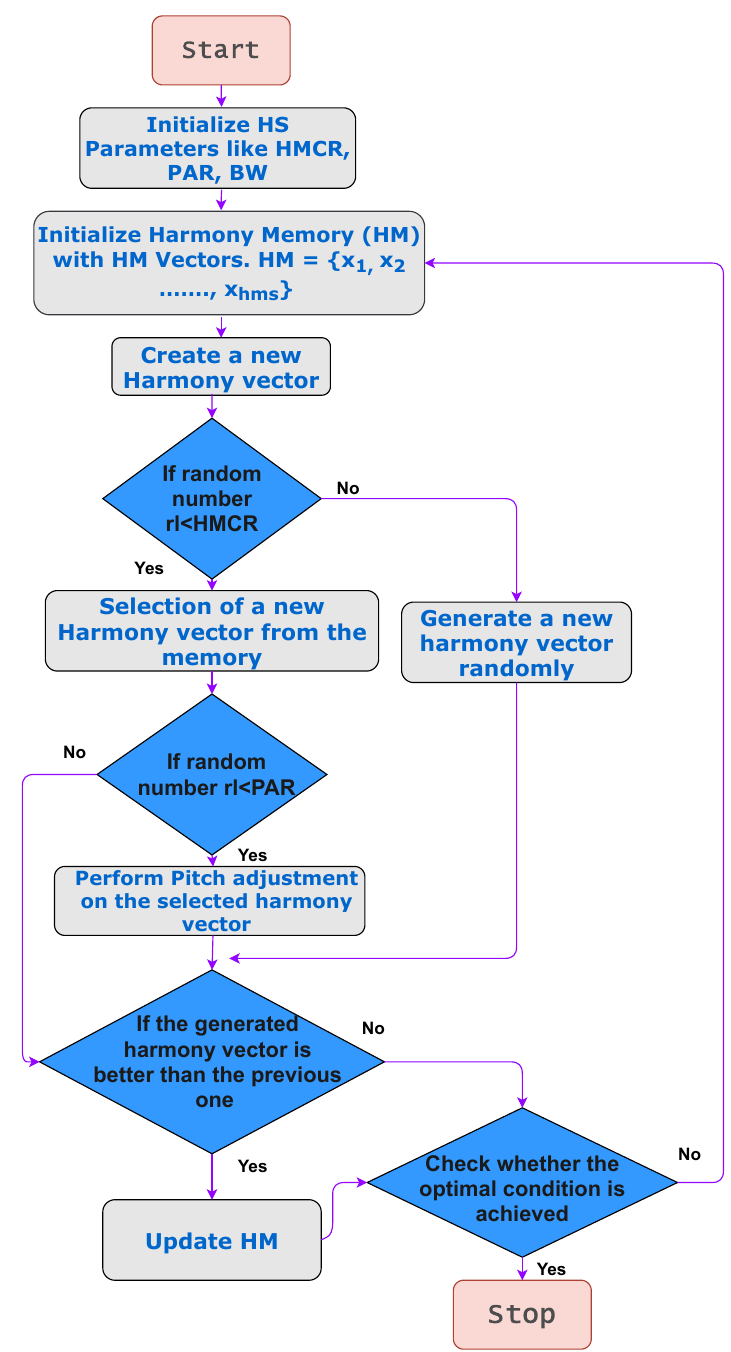
Figure 7. A flowchart representing the HS